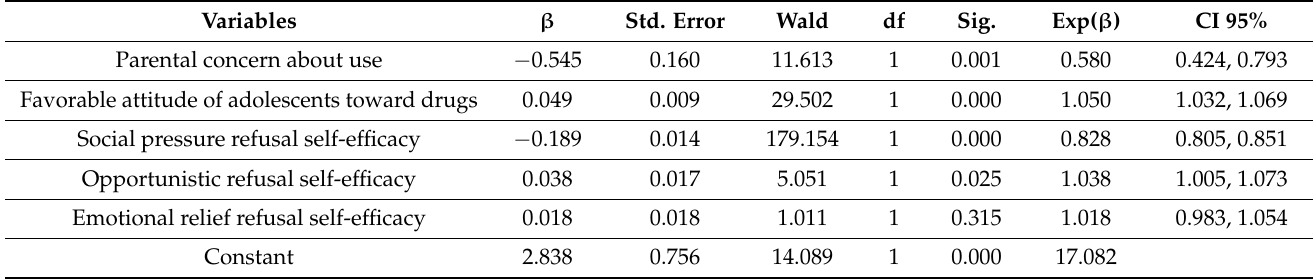
Table 6. Results of the logistic regression analysis for likelihood of drinking